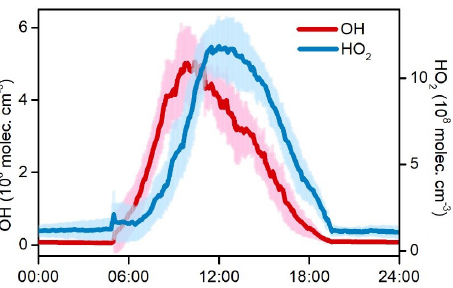
Figure 8. Simulated average diurnal variations in OH and HO 2 dur- ing the nine O 3 pollution episodes. The shaded areas indicate the standard deviations of the